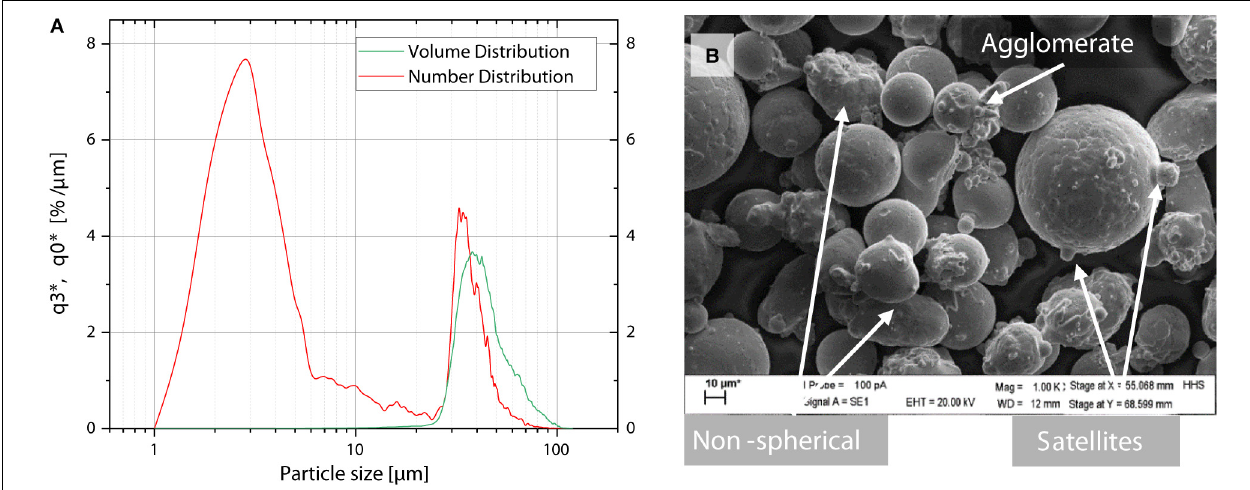
FIGURE 2 | Powder analysis results of Al9Cr17Fe36Ni38 material in 20–90 µ m fraction. (A) Particle size volume (q3) and number (q0) distribution curves scaled in (%/ µ m) vs. equivalent particle diameter ( µ m) showing one maximum in volume distribution and two maxima in number distribution, and (B) SEM image of powder material in 1000 × magnification showing mainly spherical particles and some irregular shaped particles and satellites.